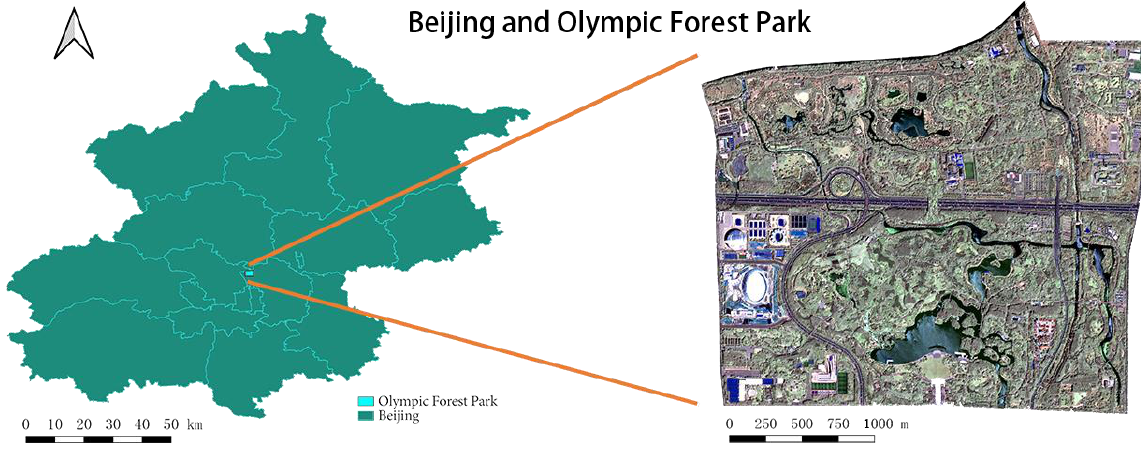
Figure 1. Research area.